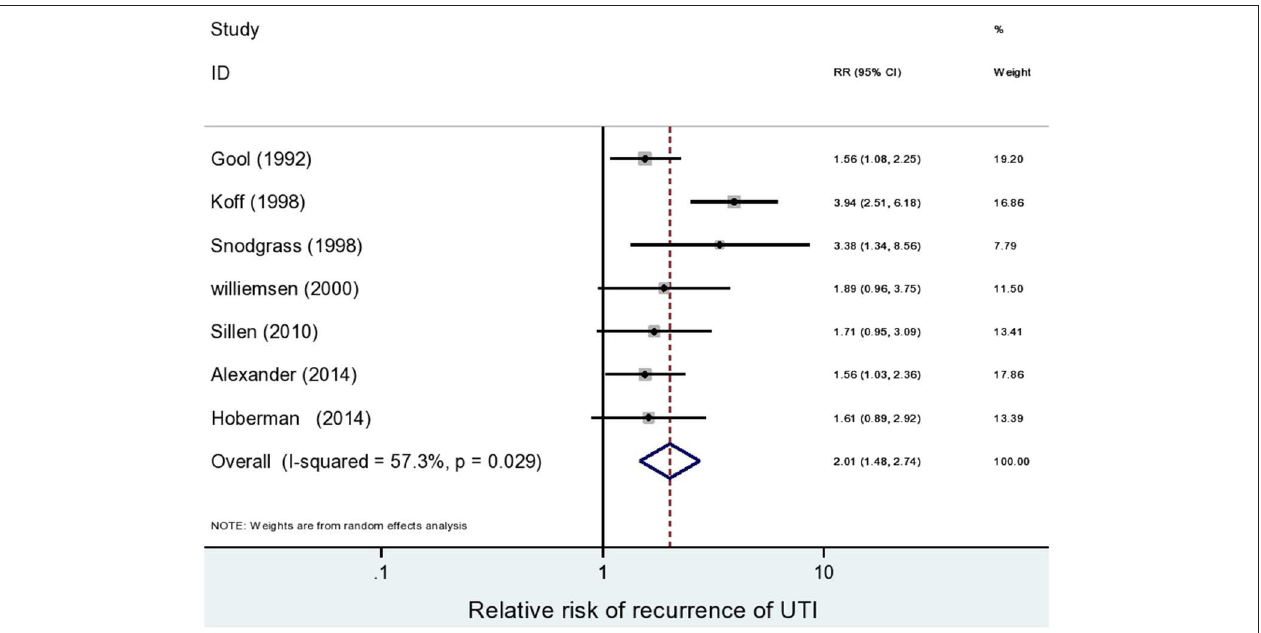
FIGURE 4 | Risk of recurrence of urinary tract infection (UTI) in patients with vesicoureteral reflux (VUR) and bladder and bowel dysfunction (BBD) compared with patients without